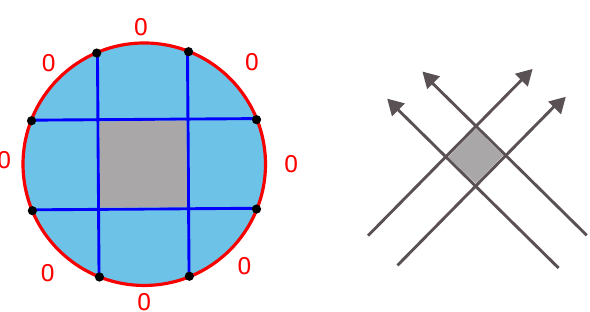
Figure 3 . Left: configuration of crossing Wilson lines that enclose a bulk region. The coset projection (denoted by the 0-symbol and the red-colored boundary) is not felt in the deep interior, but it is crucial to use the sinh 2 π √ E measure to agree with a semi-classical shockwave computation of the same topology (Right).